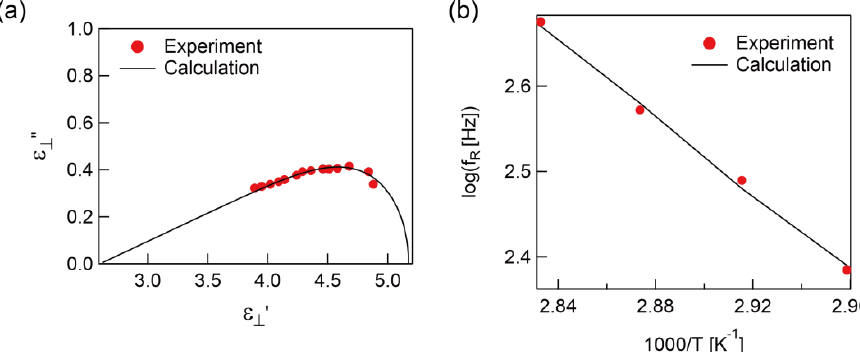
Figure 7. ( a ) The Cole-Cole plot of the polymerized sample at 343 K. ( b ) Temperature  before polymerization. The filled circles dependence of the relaxation frequencies of ε  are experimental data and the line is calculation